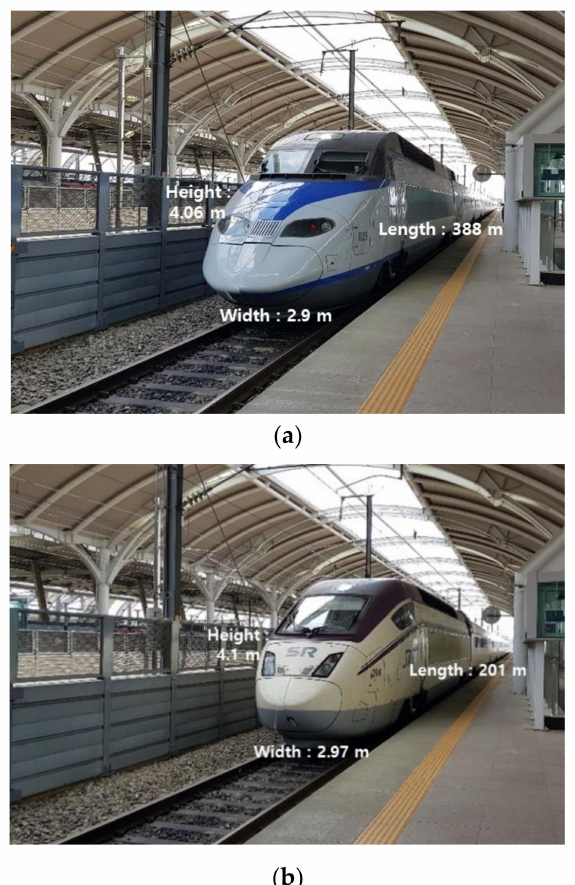
Figure 3. Two types of high-speed trains used in the experiment ( a ) KTX; ( b )